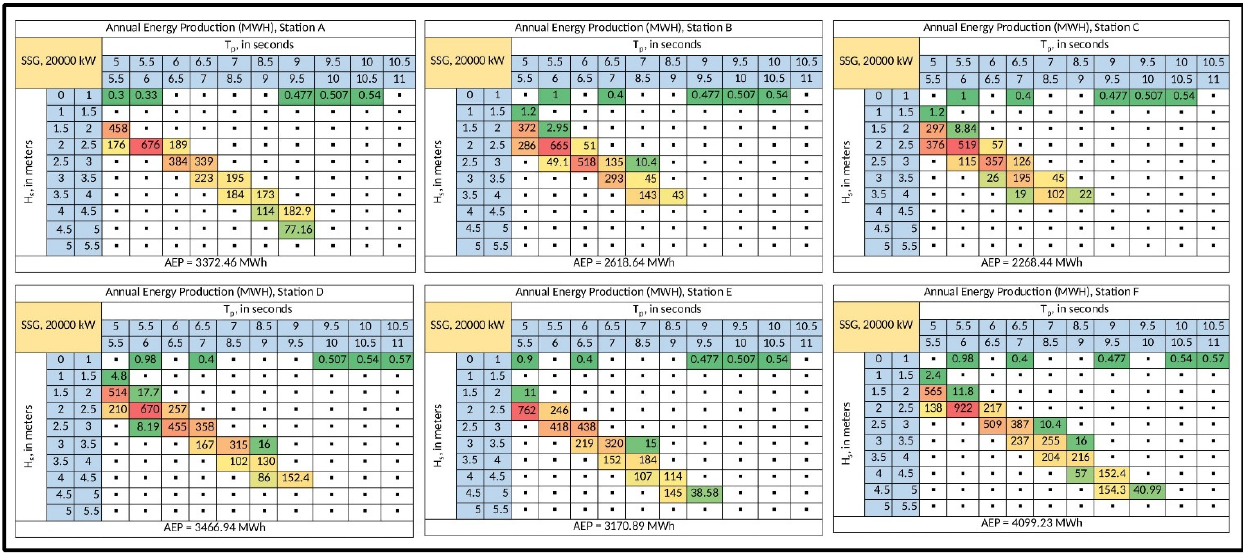
Figure A6. AEP computations of SSG at stations A–F.